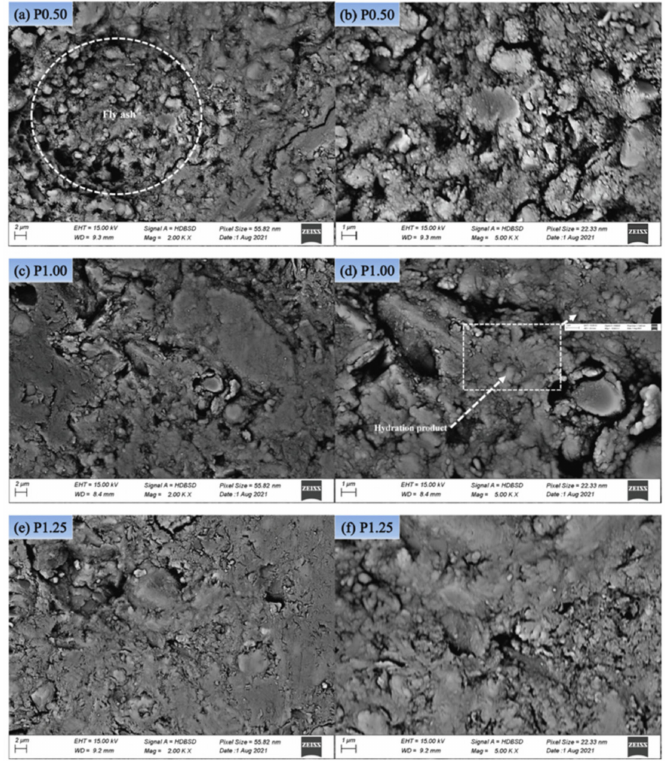
Figure 6. SEM of autoclaved lightweight aggregate with different curing pressure: ( a , b ) P0.50, ( c , d ) P1.00, ( e , f ) P1.25